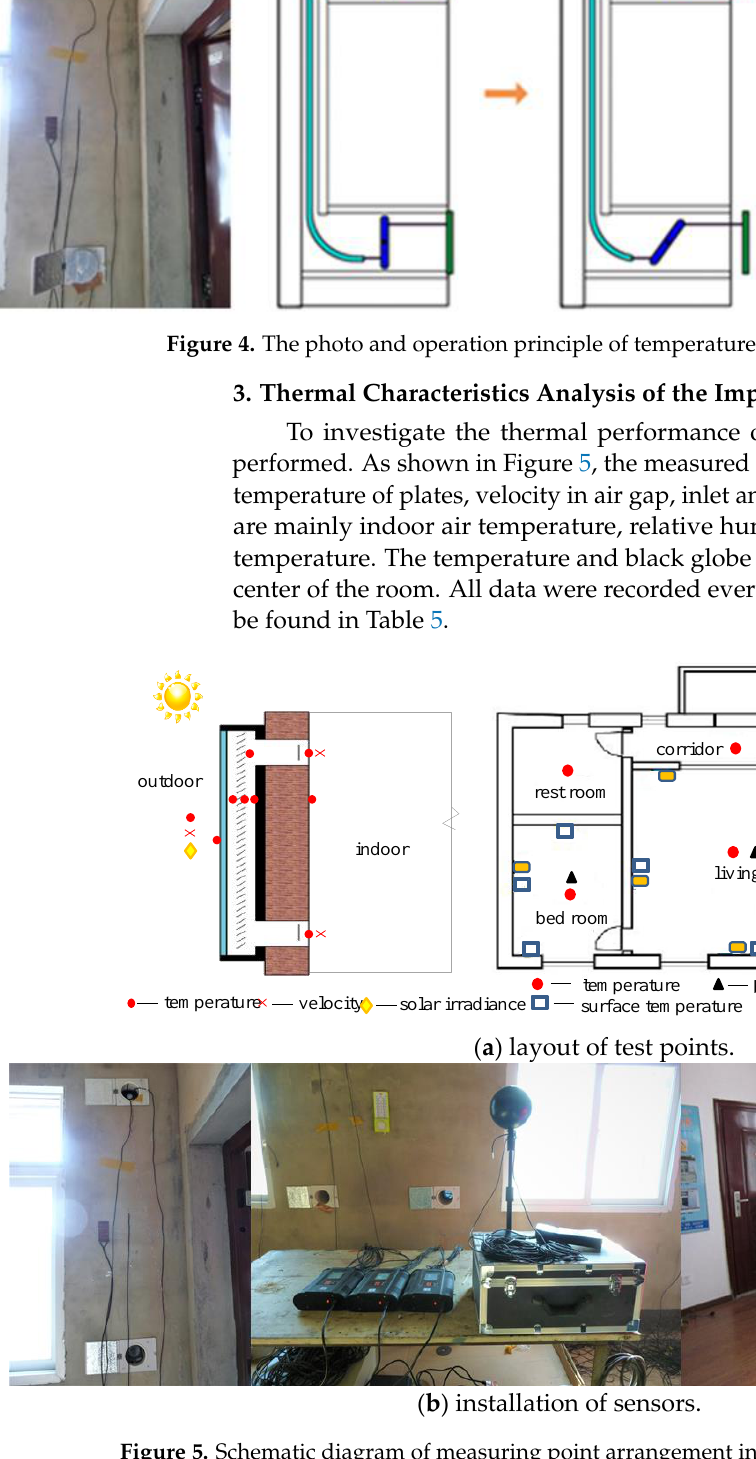
Figure 5. Schematic diagram of measuring point arrangement in the passive solar house. Table 5. Monitored data and technical specification of measuring instruments. Monitored Parameters